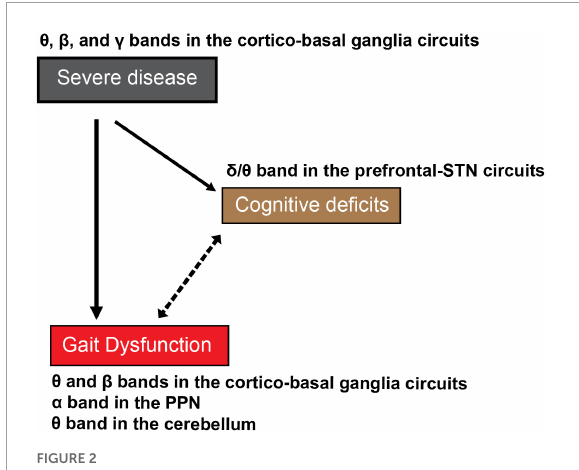
FIGURE2 The proposed cognitive deficits-related oscillations in the cortical and subcortical networks in gait dysfunction in PD. As disease severity increases with time, patients with PD exhibit cognitive deficits, as well as severe gait dysfunction. The indirect association between severe gait dysfunctions such as FOG and cognitive deficits in the advanced stage of PD remains undetermined. The reciprocal effects of disease severity and cognitive deficits-related oscillations have been proposed as the mechanism of severe gait dysfunction or FOG in PD. Continous lines indicate definite causal relation and the dotted line indicates associative mutual relationship without proven